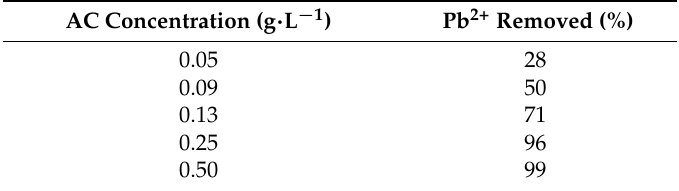
Table 5. Influence of AC concentration on percentage Pb 2+ removed from the aqueous solution.